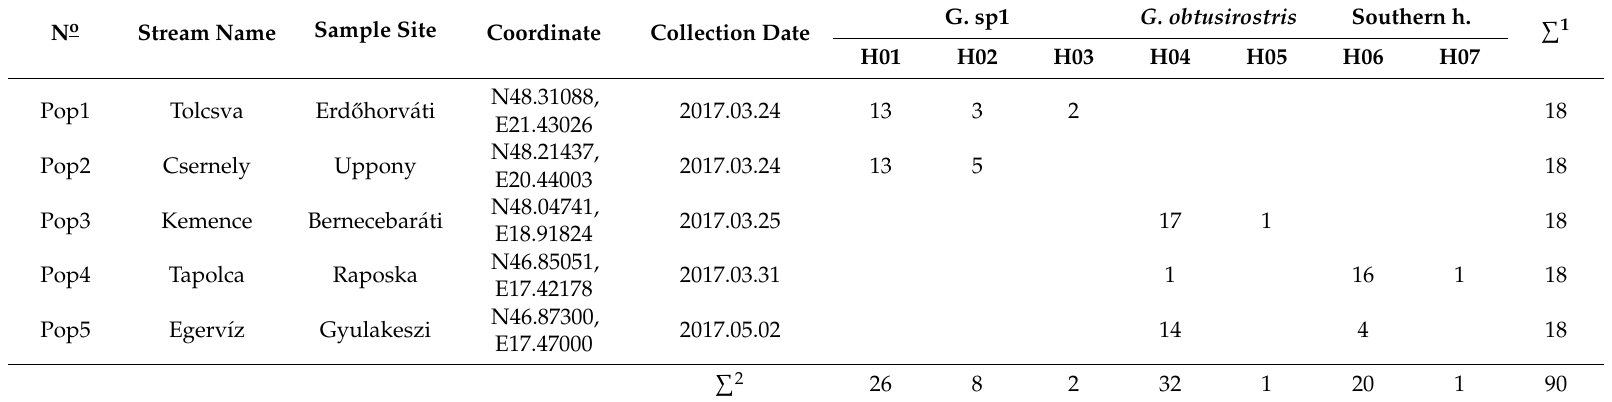
Table 1. Stream codes, names, sampling sites, coordinates, collection dates, and the number of individuals showing the same haplotype. (cid:80) 2 per site : number of individuals classified into a certain